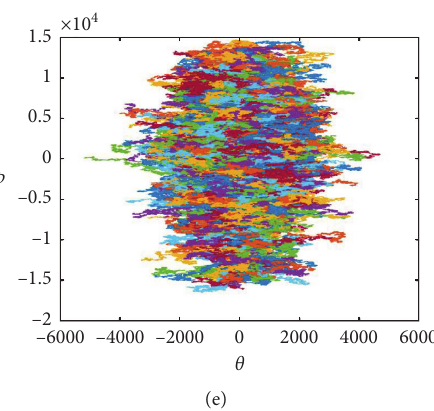
Figure 3: Harper model phase space diagram of symmetrical case: (a) L � K � 0 . 2; (b) L � K � 0 . 4; (c) L � K � 0 . 63; (d) L � K � 4; (e) L � K �